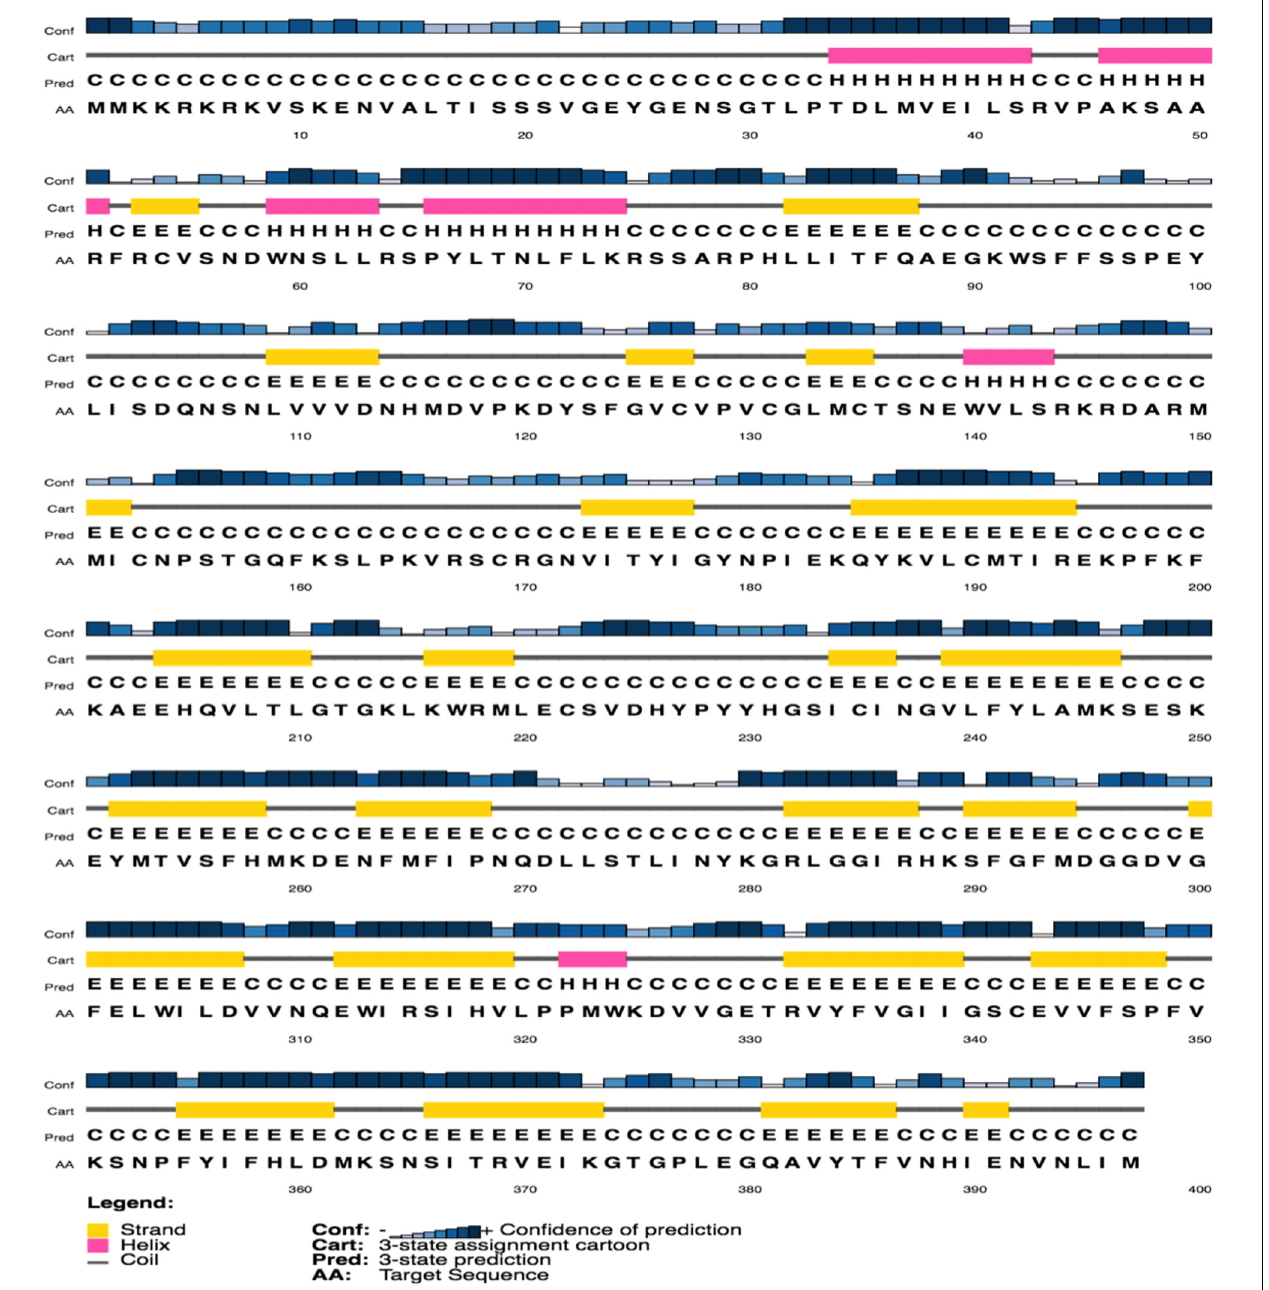
FIGURE 10 | Predicted secondary structure of 3p.AtFBP113 protein. The secondary structure of 3p.AtFBP113 shows that the β -strands (yellow cylinders) are the most abundant secondary structural elements followed by α -helices (pink cylinders). Moreover, the coils (gray lines) are also abundant in the secondary structure of